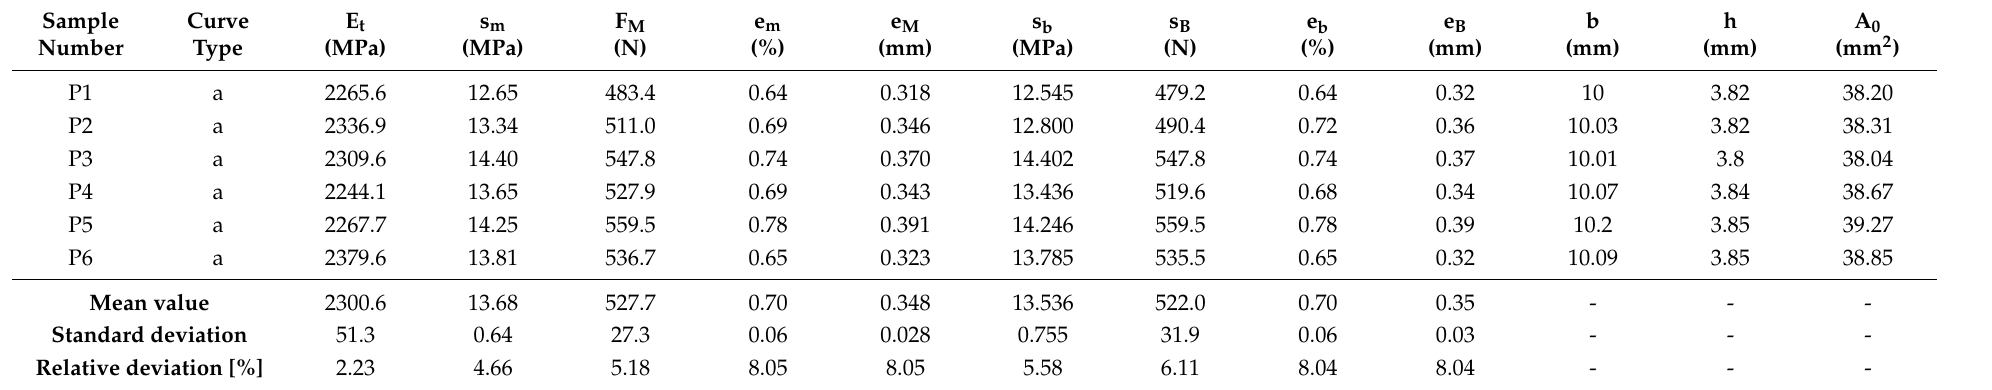
Table A35. Results of the tensile tests of